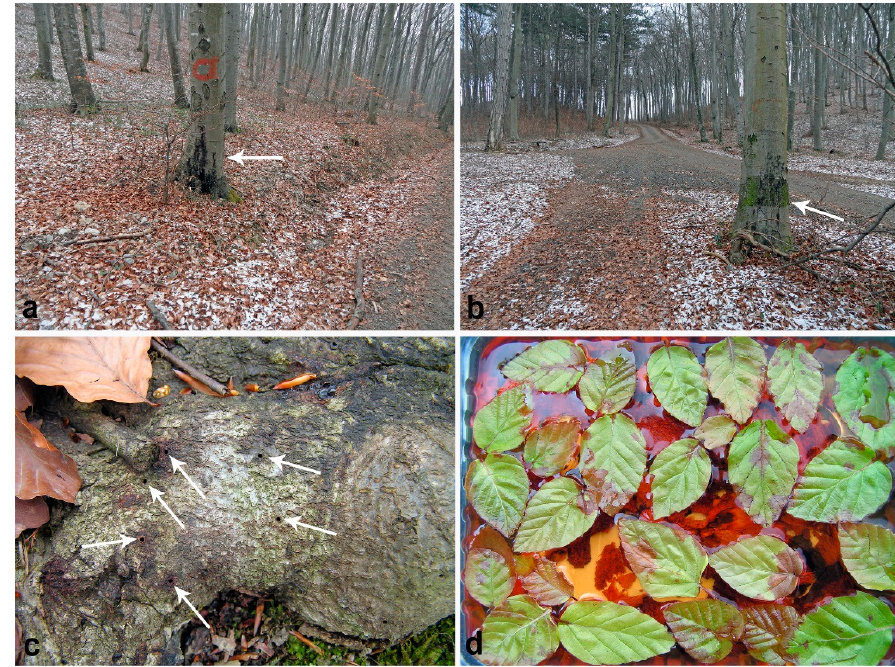
Figure 3. ( a , b ) Bleeding collar rot lesions caused by Phytophthora × cambivora on Fagus sylvatica trees along forest roads in stand F15 Haspelwald 2; ( c ) surface root of a beech tree in stand F16 Hengstlberg with exit holes of the bark beetle Taphrorychus bicolor being mostly connected to the bleeding bark lesions caused by P . × cambivora ; ( d ) baiting test from an inactive aerial canker of a beech tree in stand F17 Hocheck 2 with lesions on F. sylvatica baiting leaves caused by P. plurivora .